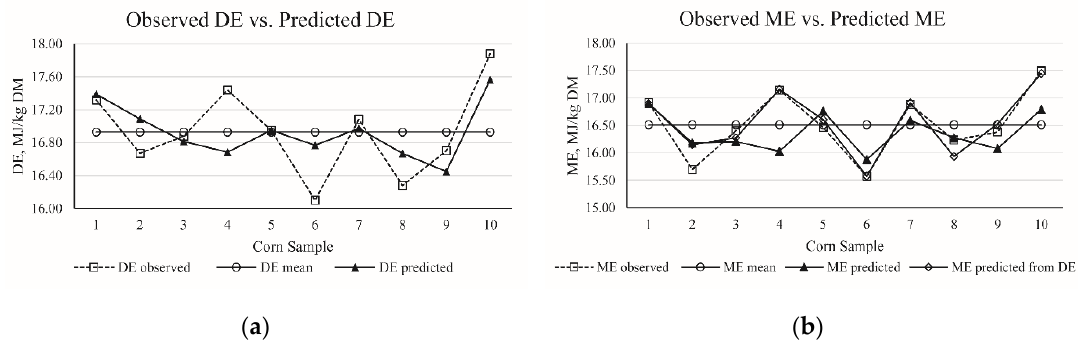
Figure 1. ( a ) The distribution of observed digestible energy (DE) of corn and predicted DE of corn calculated from best-fit equation in present study; ( b ) the distribution of observed metabolism energy of corn (ME), predicted ME of corn from DE, and predicted ME of corn calculated from the best-fit equation in present study.